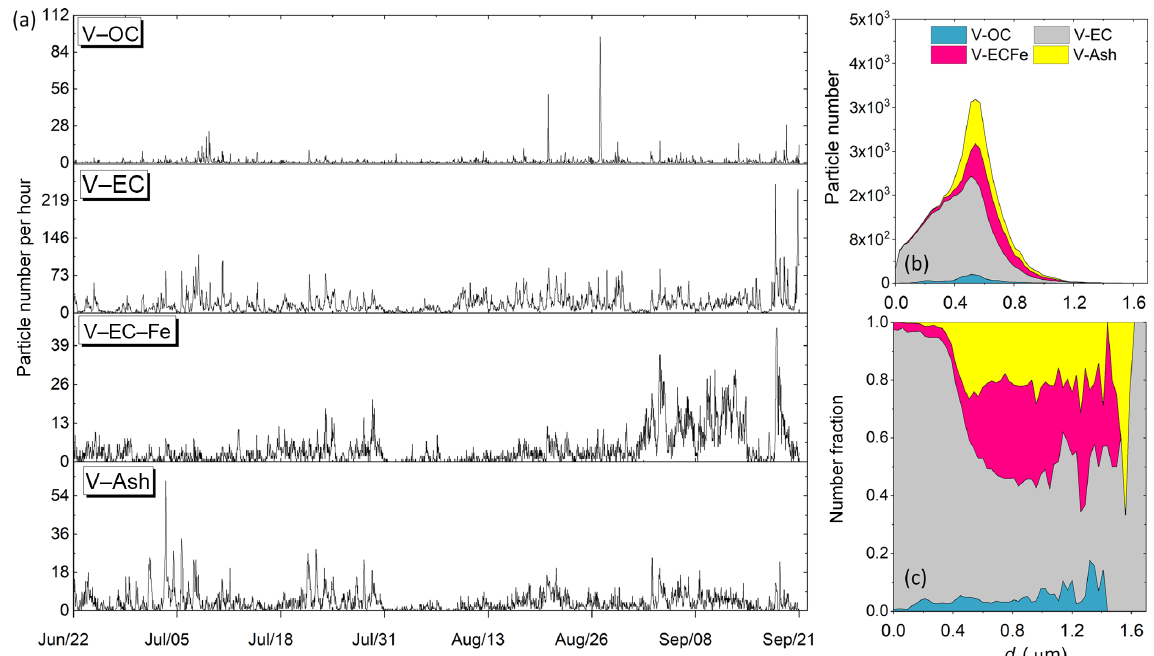
Figure 7. Temporal trends of particle numbers detected per hour by SPAMS for the four fresh vanadium particle types (a) . The number–size distribution of the four particle types, with the y axis representing the particle numbers detected at each size bin at constant flow during the entire study (b) . Panel (c) is obtained by normalizing the particle numbers of the four types to give their relative contributions at each size.